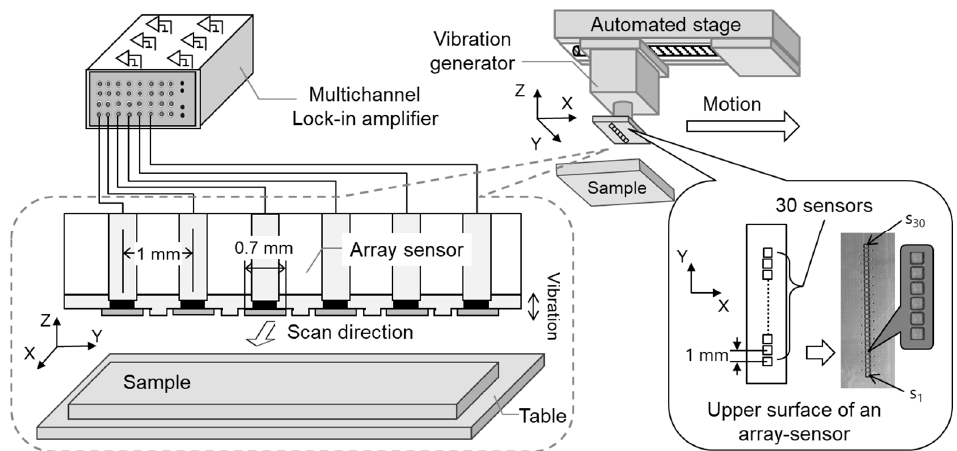
Figure 1. Experimental system for measuring static charge distribution.